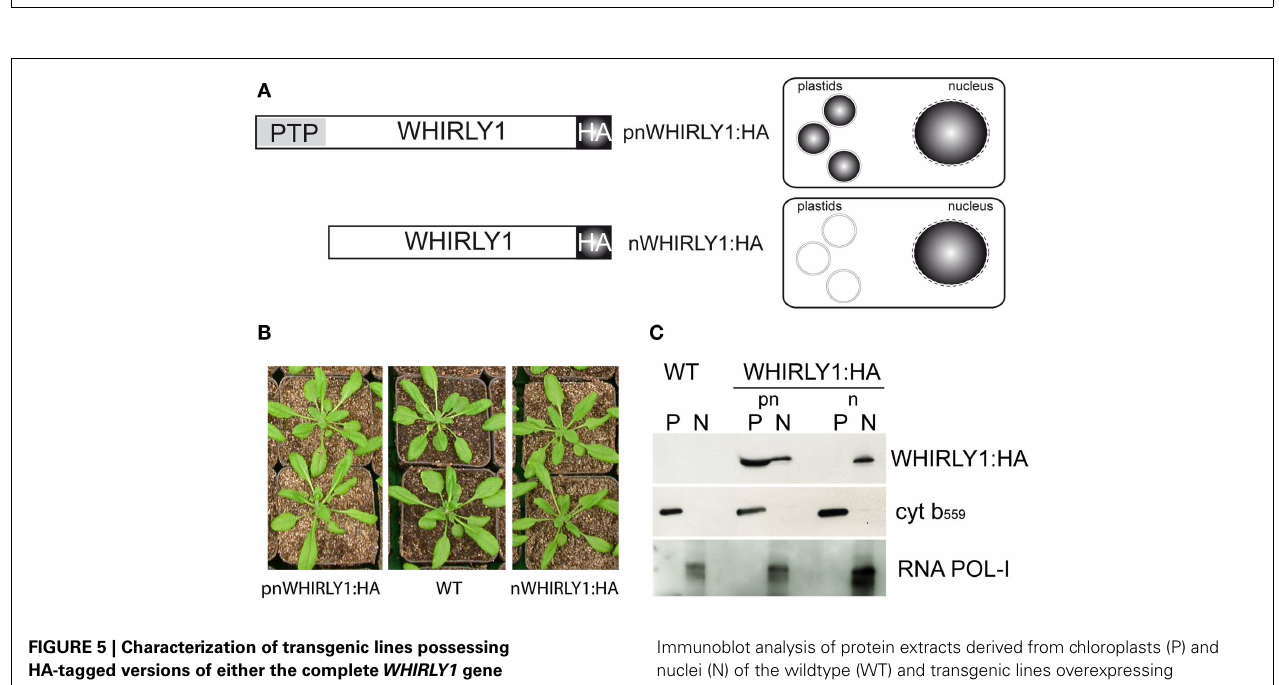
FIGURE 4 | Inhibition of germination by abscisic acid and salicylic acid in gun mutants. In order to investigate the germination of gun mutants in the presence of abscisic acid (ABA) (A) and salicylic acid (SA) (B) , respectively, seeds of the well described gun mutants gun1-1 , gun1-102 , and gun5 were grown on agar medium containing 2–20 µ M ABA or 0.2–1mM SA.The percentage of seeds showing radicle emergence was scored after 7days of